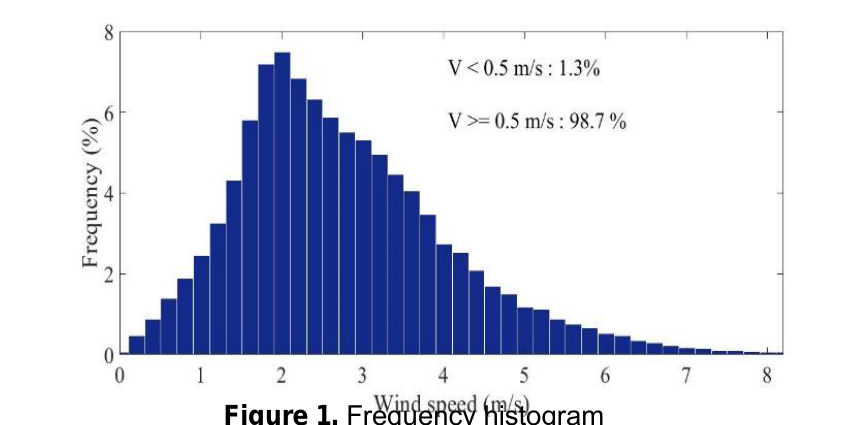
Figure 1. Frequency